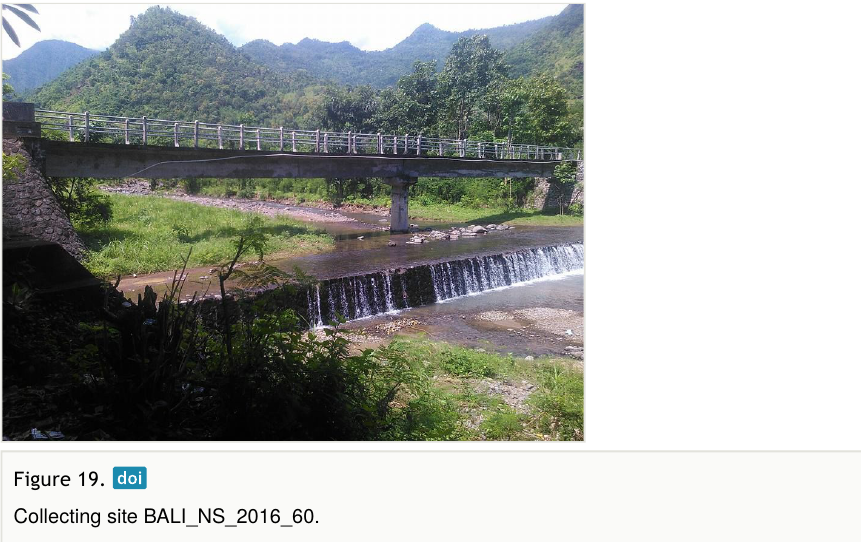
Geographic range outside Bali: Sunda islands as far east as Sumba, Sulawesi. Ecology The species is occupies stagnant water habitats with emergent vegetation or pools on rocky / gravelly ground at the edge of streams and creeks, sometimes also roadside pools (Figs 19, 20).